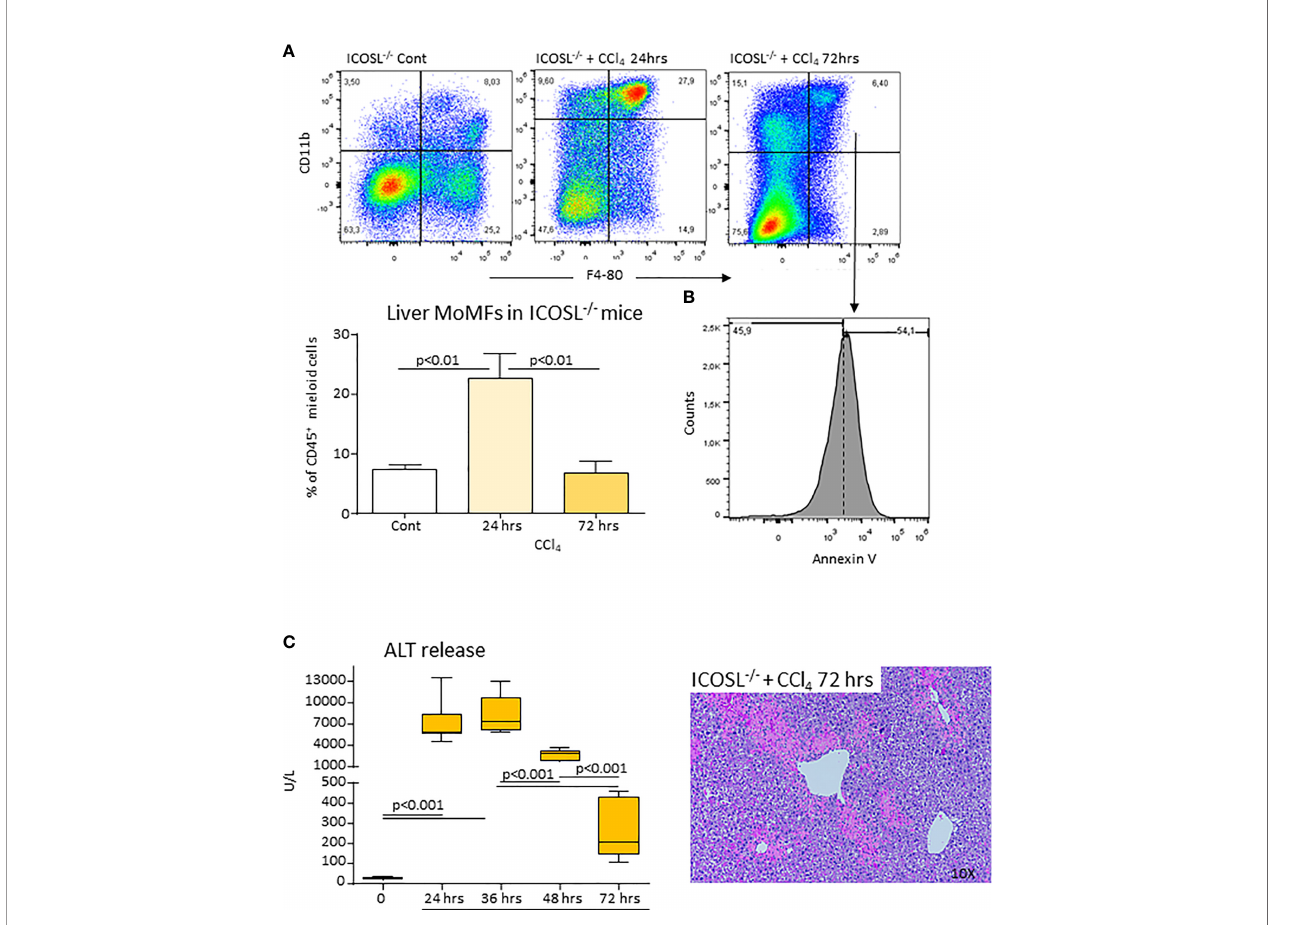
FIGURE 8 | ICOSL de fi ciency of impairs MoMF survival and liver healing following acute liver injury. Wild-type and ICOSL -/- mice received CCl 4 for 72 hours. The liver prevalence of MoMFs (A) and the expression of the apoptosis marker annexin V (B) were evaluated by fl ow cytometry. The evolution of liver damage was monitored by circulating alanine aminotransferase (ALT) and liver histology of liver sections stained with hematoxylin/eosin (magni fi cation 10X) (C) . The results are expressed as mean ± SD of 3-5 animals for each time